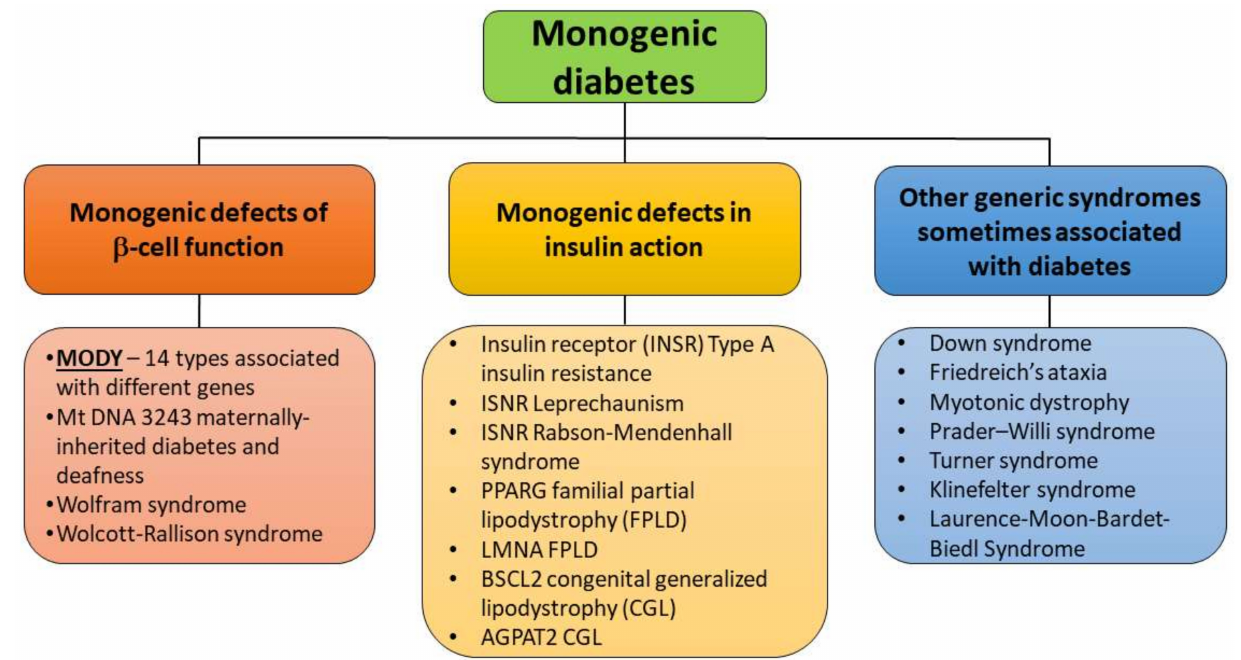
Figure 2. Subclassification of the monogenic diabetes (based on WHO, 2019